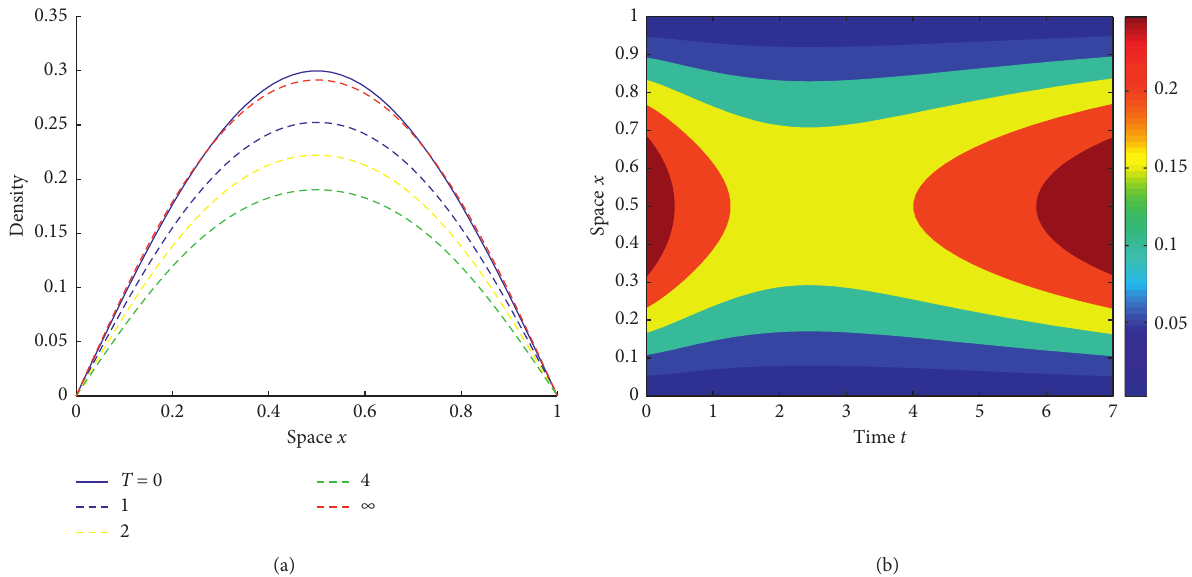
Figure 2: The corresponding cross-sectional view (a) and contour one (b) for the solution of problems (7) and (9), which means that the domain is fixed when the evolution rate ρ ( t ) �